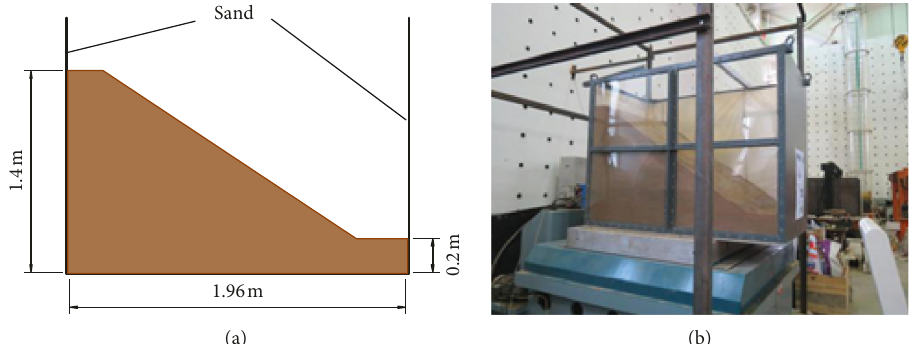
Figure 9: The small slope model (reproduced from the study of Huang et al. [20], under the Creative Commons Attribution License/public domain).